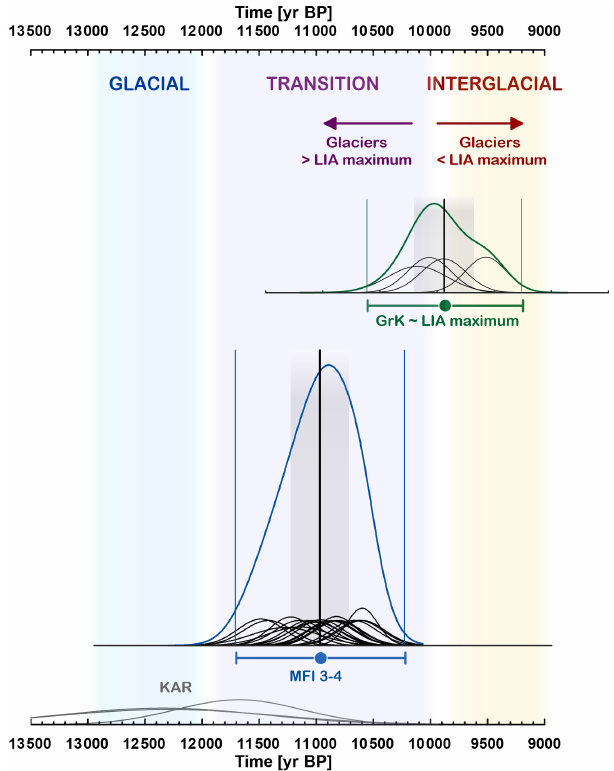
Figure 10. Glacier retreat during the transition from glacial to in- terglacial conditions evidenced in moraine chronologies from the Silvretta and Verwall regions. KAR indicates Kartell moraines (Ivy- Ochs, 2015; Ivy-Ochs et al., 2006). The site is located approxi- mately 15–20km northeast of Jamtal and Laraintal. MFI 3–4 are as described in this study. GrK indicates the Grüne Kuppe moraine identified in the adjacent Ochsental, suggesting LIA-like glacier ex- tents around 10000calBP (Braumann et al.,